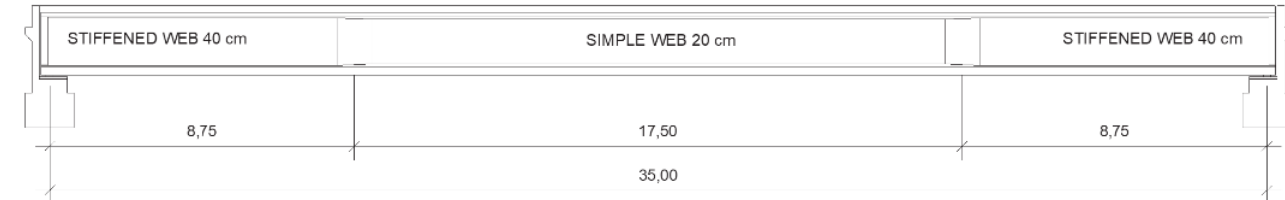
Figure 2 Longitudinal elevation of the deck (dimensions in